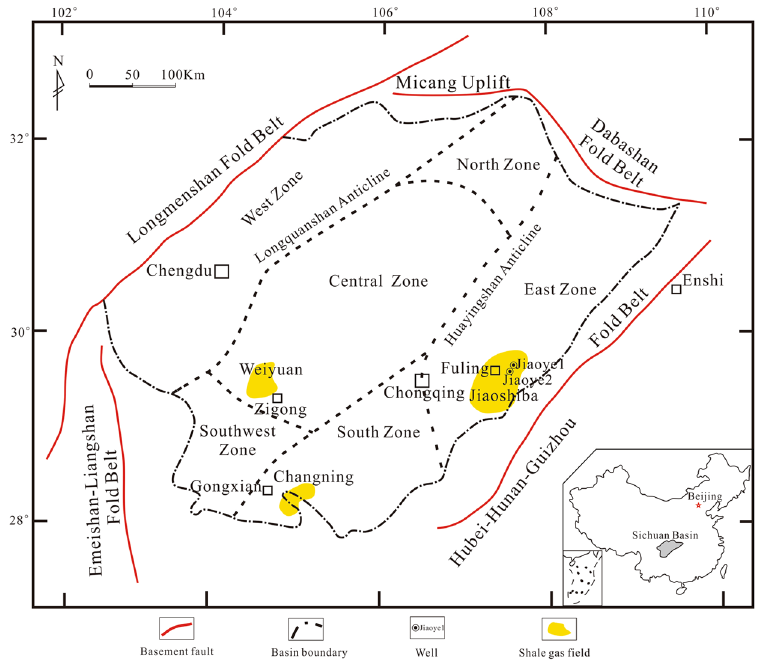
Figure 1. Location map. Map of study area showing major shale gas fields and typical wells of the Wufeng- Longmaxi Formations in the Sichuan Basin and its surrounding